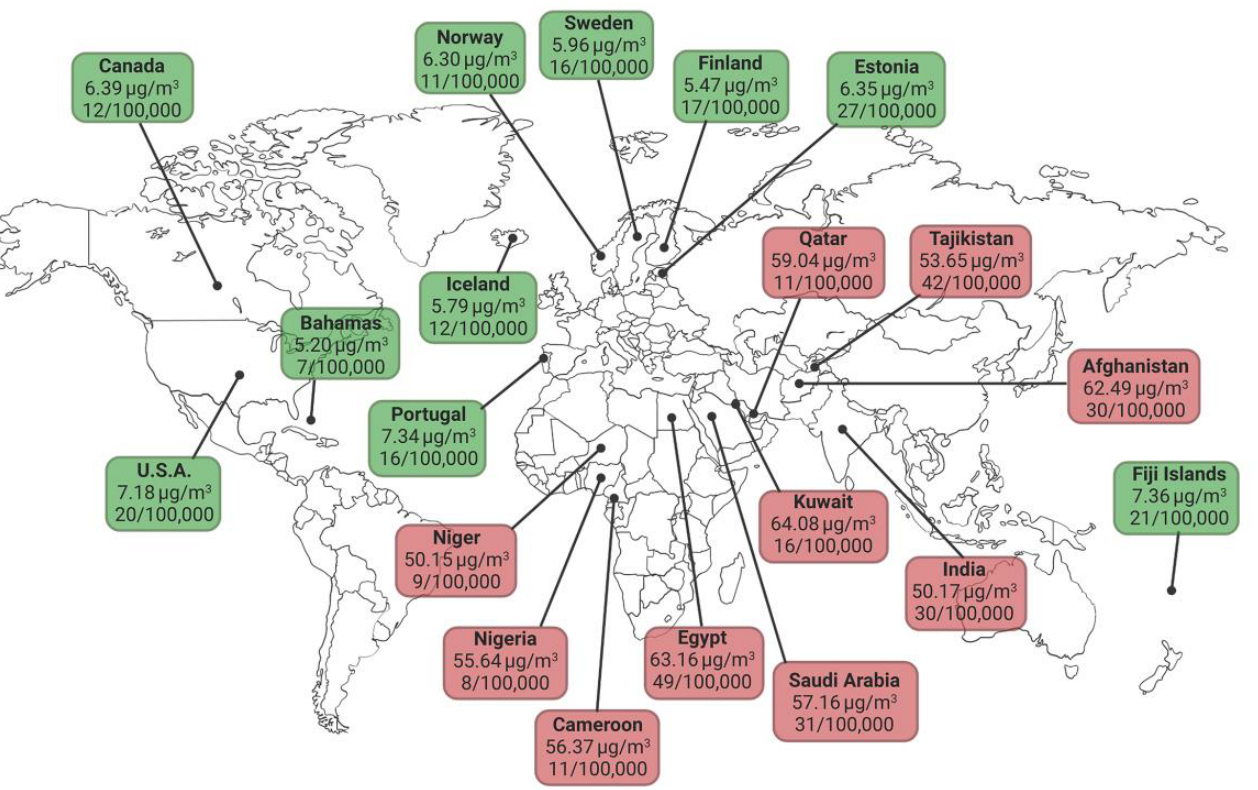
Figure 1. WHO estimates of air pollution and death rates for ischemic heart disease in 2019. Levels of PM 2.5 in the ten less polluted countries (green tags) and the ten more polluted countries (red tags), according to the World Health Organization (WHO) Observatory data. For each country the air pollution attributable death rate (expressed as number of deaths per 100,000 population per year) for ischemic heart disease is also indicated. Created with BioRender.